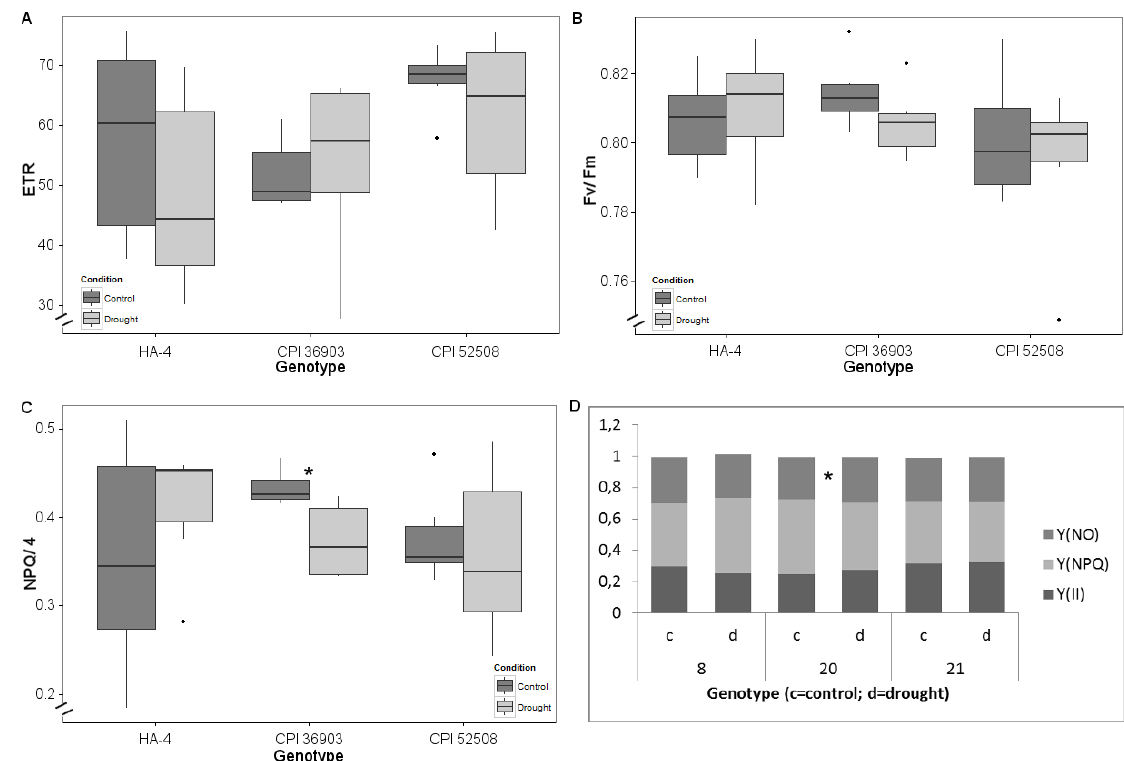
Fig. 5: Effects of water limitation after eight days on (A) ETR, (B) Fv/ Fm and under LL conditions through chlorophyll fluorescence measurements (C) NPQ/4, (D) Y(II) Y(NO) Y(NPQ); n=6, genotypes with * = p <0.05, exp.